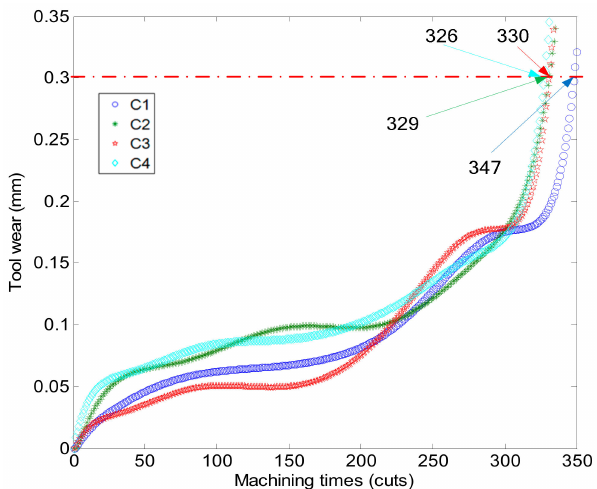
Figure 15. The polynomial curve of the tool wear.